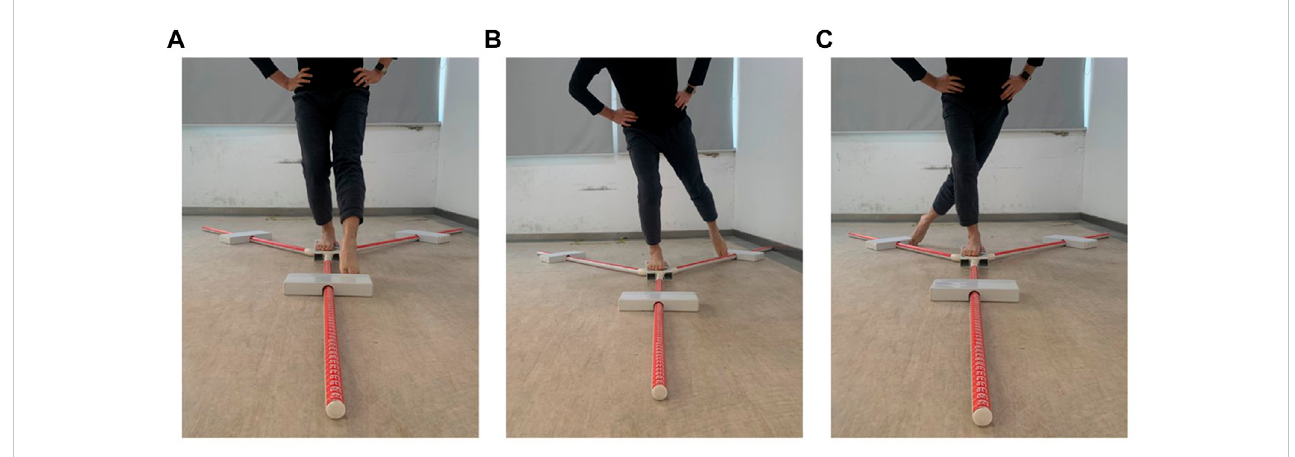
The Y balance test. (A) anterior direction; (B) posteromedial direction; (C) posterolateral